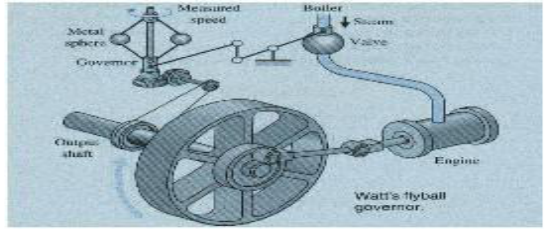
Figure 1: Watt invented the steam